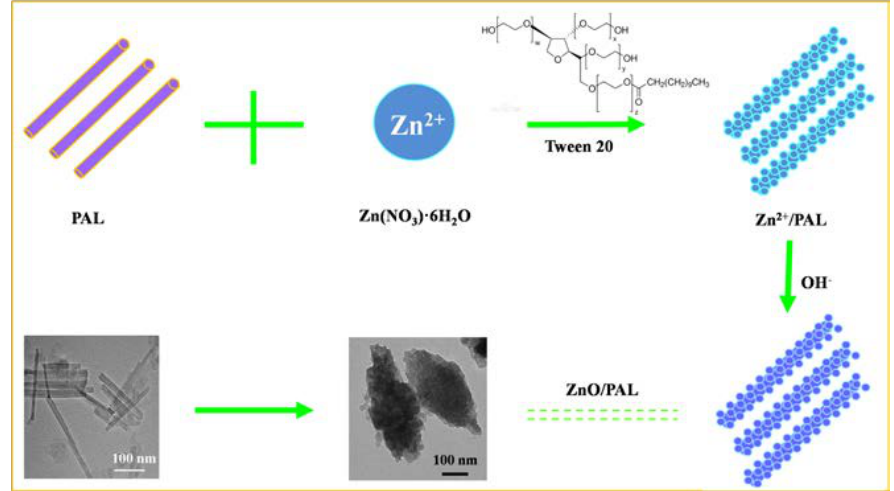
Figure 5. Schematic illustration for the preparation of spindle-like ZnO/PAL.